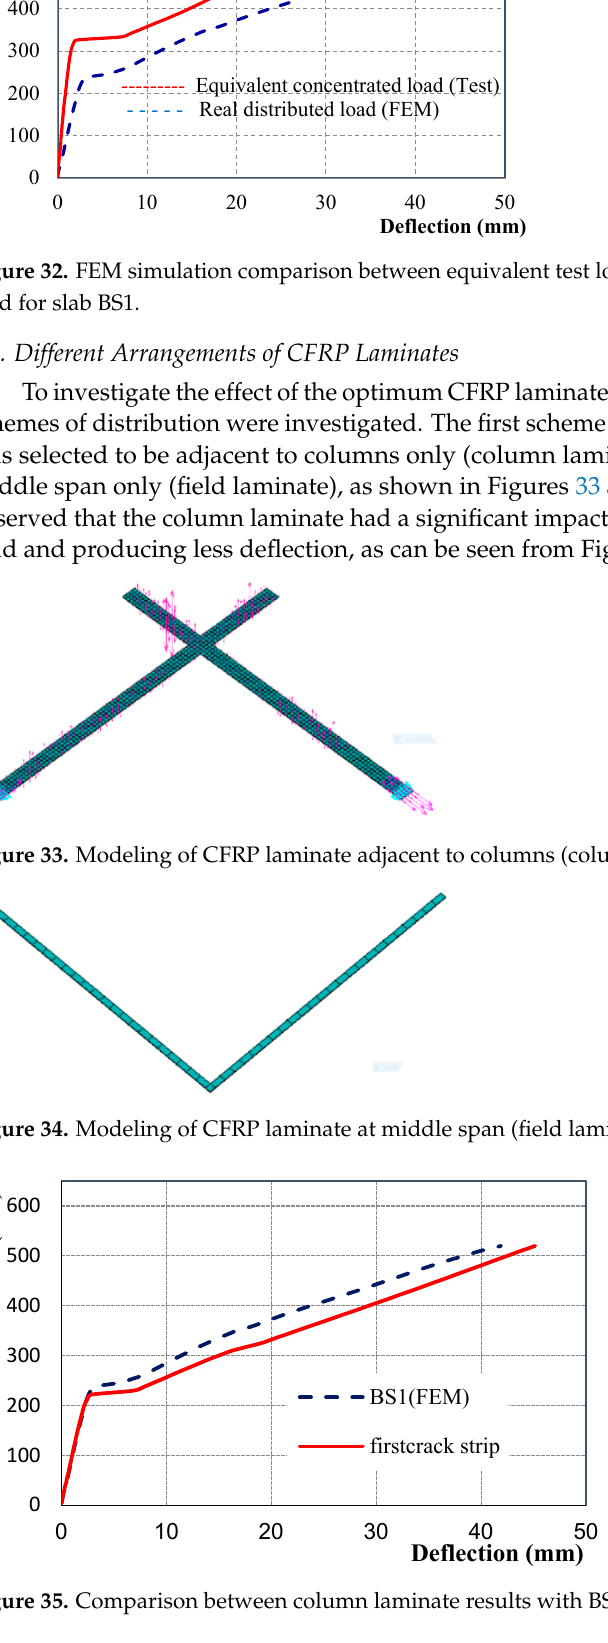
Figure 36. Comparison between field laminate results with BS1. 6.3. PT to CFRP Strength Contribution As shown in Figures 37–39, different ratios of PT cables (tendons) to CFRP laminates were selected to investigate the strength contribution and how efficient is the use of CFRP strengthening in different cases. From the graphs, it is concluded that the strengthening of CFRP laminates is more significant in cases of low PT reinforcement than that in high PT reinforcement.